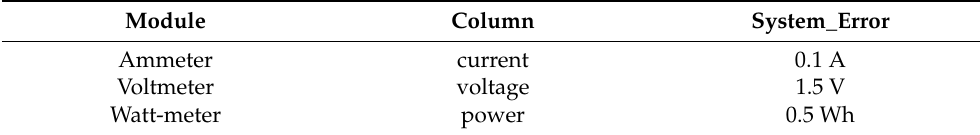
Table 3. An example of the MODULE_COLUMN